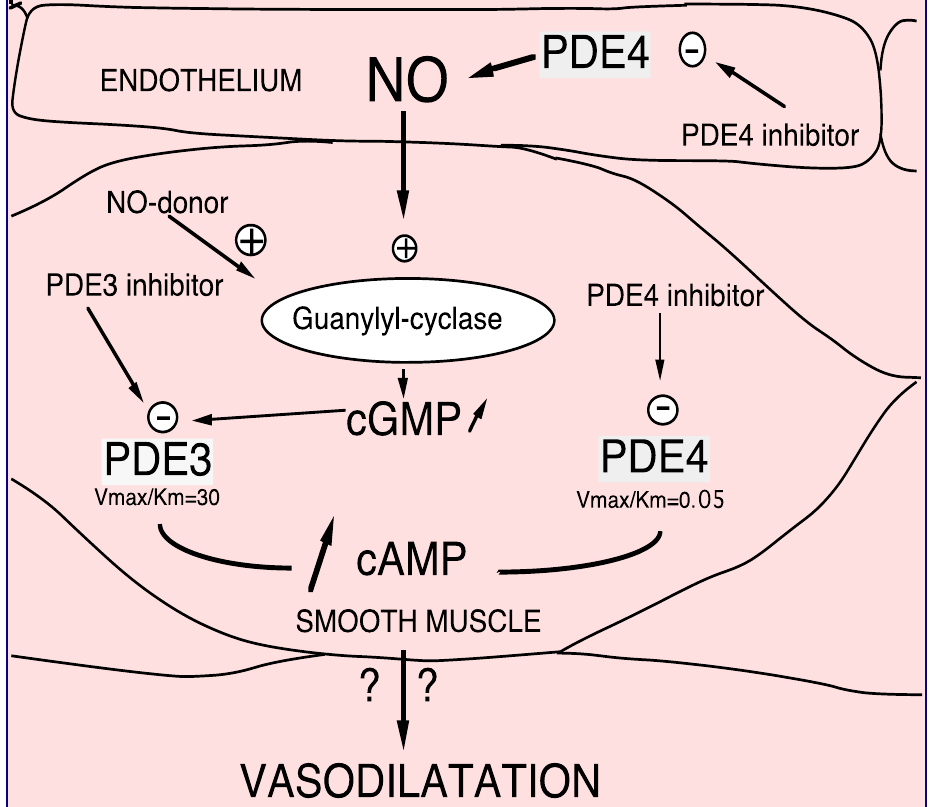
Figure 5. PDE3 and PDE4 cross-talk in vasodilation. NO or NO donor, by increasing soluble guanylyl cyclase, increases intracellular cGMP level. Therefore, this increase in cGMP induces preferentially PDE3 inhibition and consequently, an increase in cAMP in smooth muscle cells. In that way PDE4 might be able to hydrolyze cAMP in that way, PDE4 inhibitors inhibit PDE4 activity. In the presence of endothelial cells this effect is potentiated. Altogether, increases in cAMP altogether induces vasodilatation which might be potentiated in the presence of endothelium [38–41]. Moreover, it should be noted that PDE4 is mainly present in human endothelial cells [43–46]. Surprisingly, in the presence of L-arginine, the PDE4 inhibitor, rolipram, is able to increase cGMP levels by upregulating the L-arginine/NO/cGMP pathway, revealing a cross-talk between PDE4 and cGMP regulation [47] (Figure